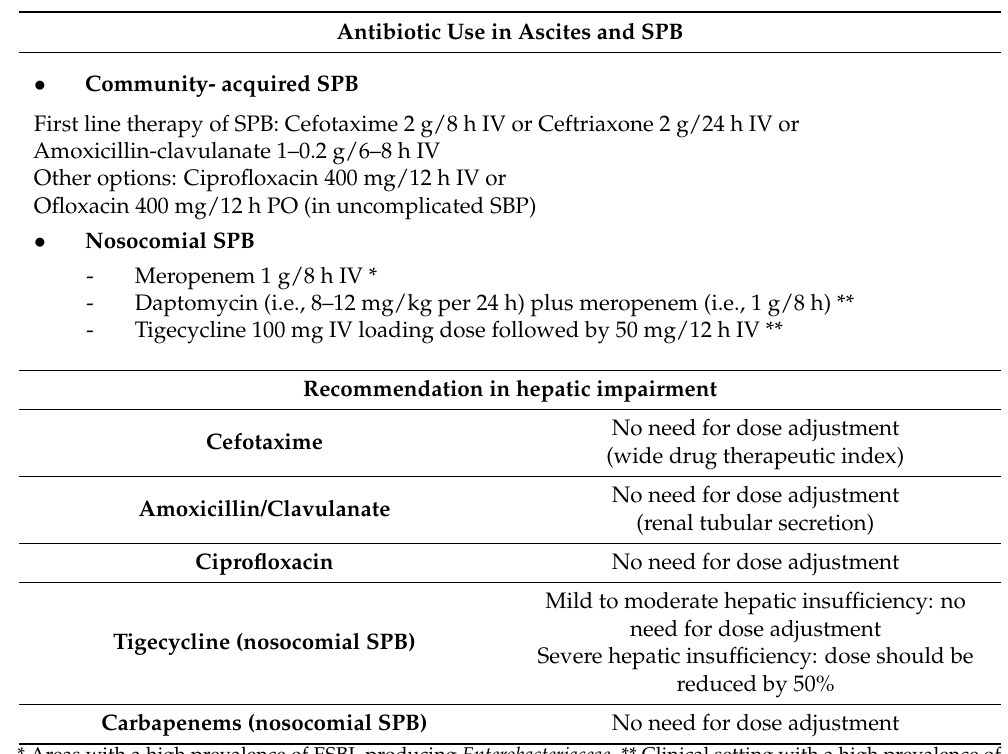
Table 1. Antibiotic use in ascites and